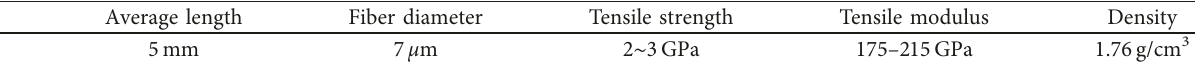
Table 2: Physical properties of carbon